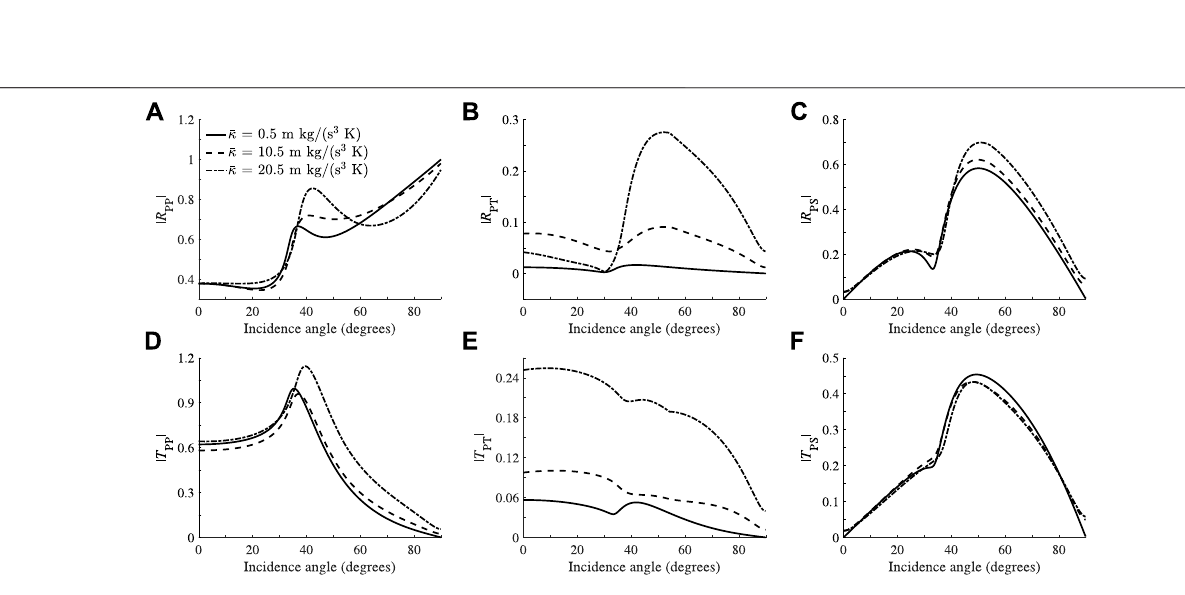
Frontiers in Earth Science |